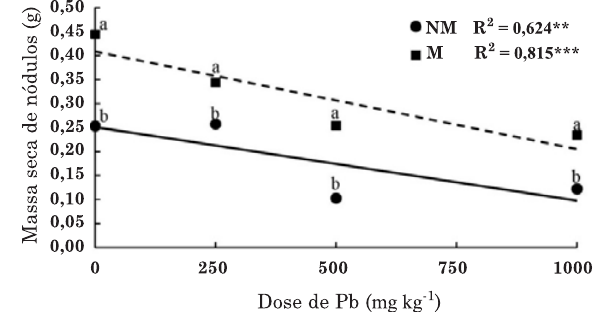
Figura 3. Massa de matéria seca de nódulos de plantas de Stizolobium aterrimum não micorrizadas (NM – linha contínua) e micorrizadas (M – linha tracejada) crescendo em solo contaminado com Pb. Letras iguais não